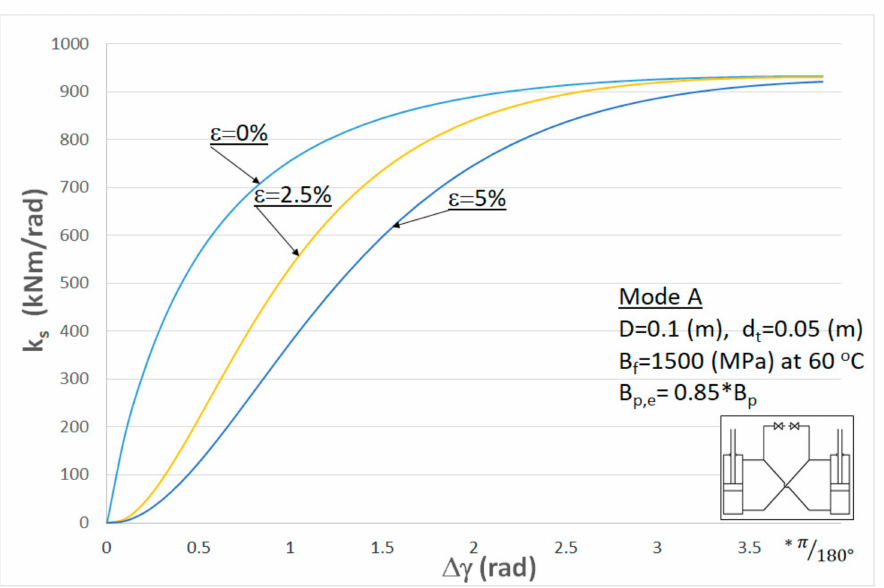
Figure 16. Results of calculations of the effective stiffness k s of the test machine’s steering system (mode A) with the flexible hydraulic